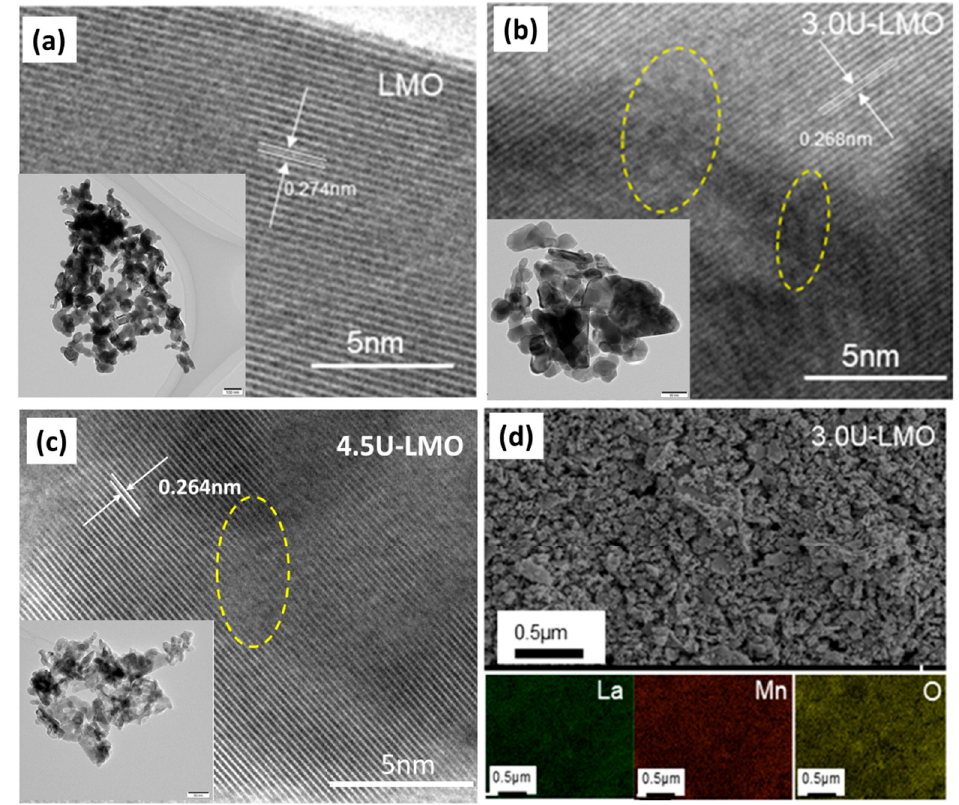
Figure 3. ( a – c ) TEM images of LMO, 3.0U-LMO, and 4.5U-LMO; ( d ) SEM images and element mappings of 3.0U-LMO.